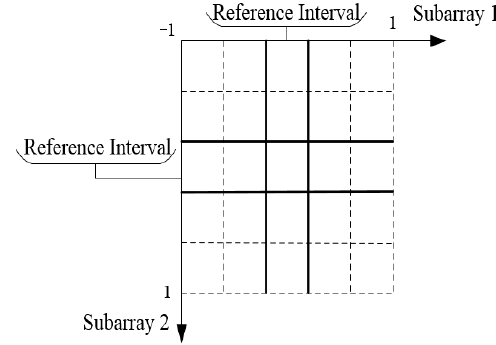
Figure 3. Constructing the lookup table (LUT).